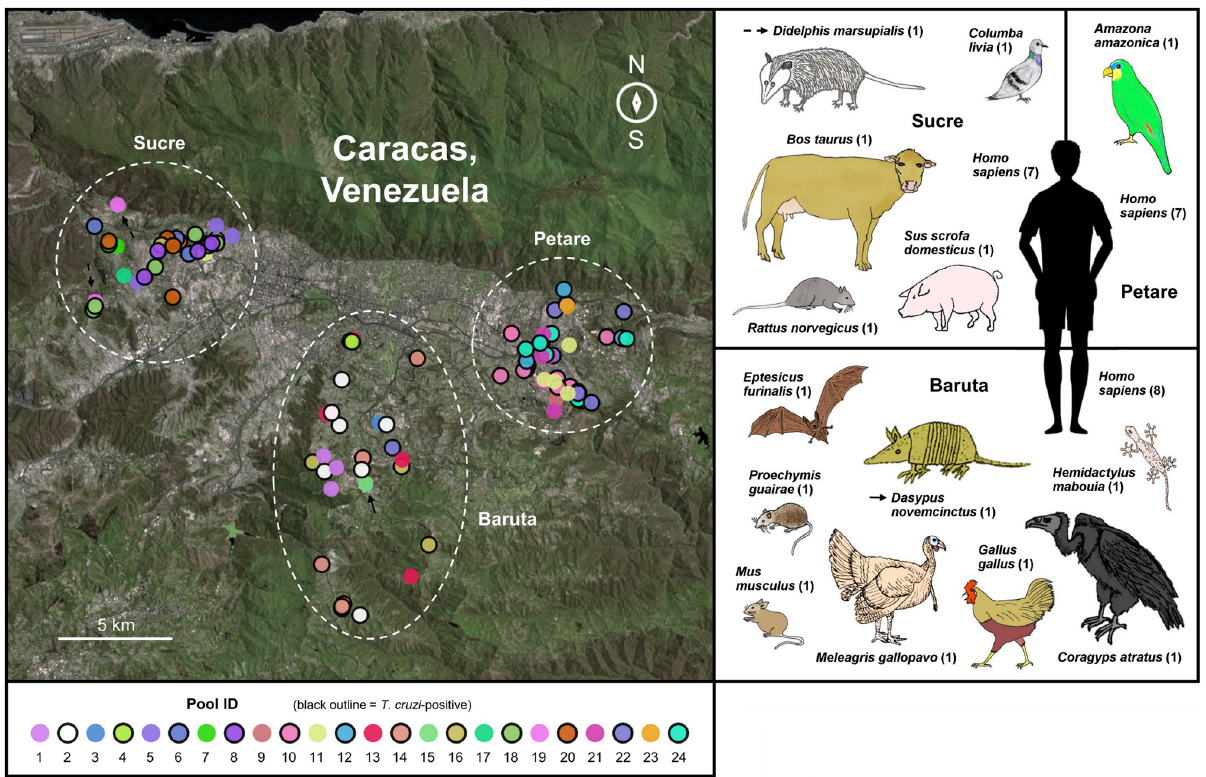
Fig 4. Vertebrate DNA sources identified in 108 pooled P . geniculatus bloodmeals from Petare, Baruta, and Sucre parishes for the MDC collection period 2009–2016. Points in the map indicate the geographical origin of the 108 samples contributing to the 24 dissection pools used in cytb analysis. Point fill color indicates pool membership. Pools composed of T . cruzi -positive samples are outlined in black. Arrows indicate pools presenting cytb DNA from the T . cruzi reservoir species D . marsupialis and D . novemcinctus . Numbers in parentheses indicate the number of pools in which the corresponding vertebrate blood source was detected. The map base layer represents Scene ID LC80040532015120LGN01 from the Landsat 8 OLI/TIRS C1 Level-1 dataset–courtesy of the U.S. Geological Survey.